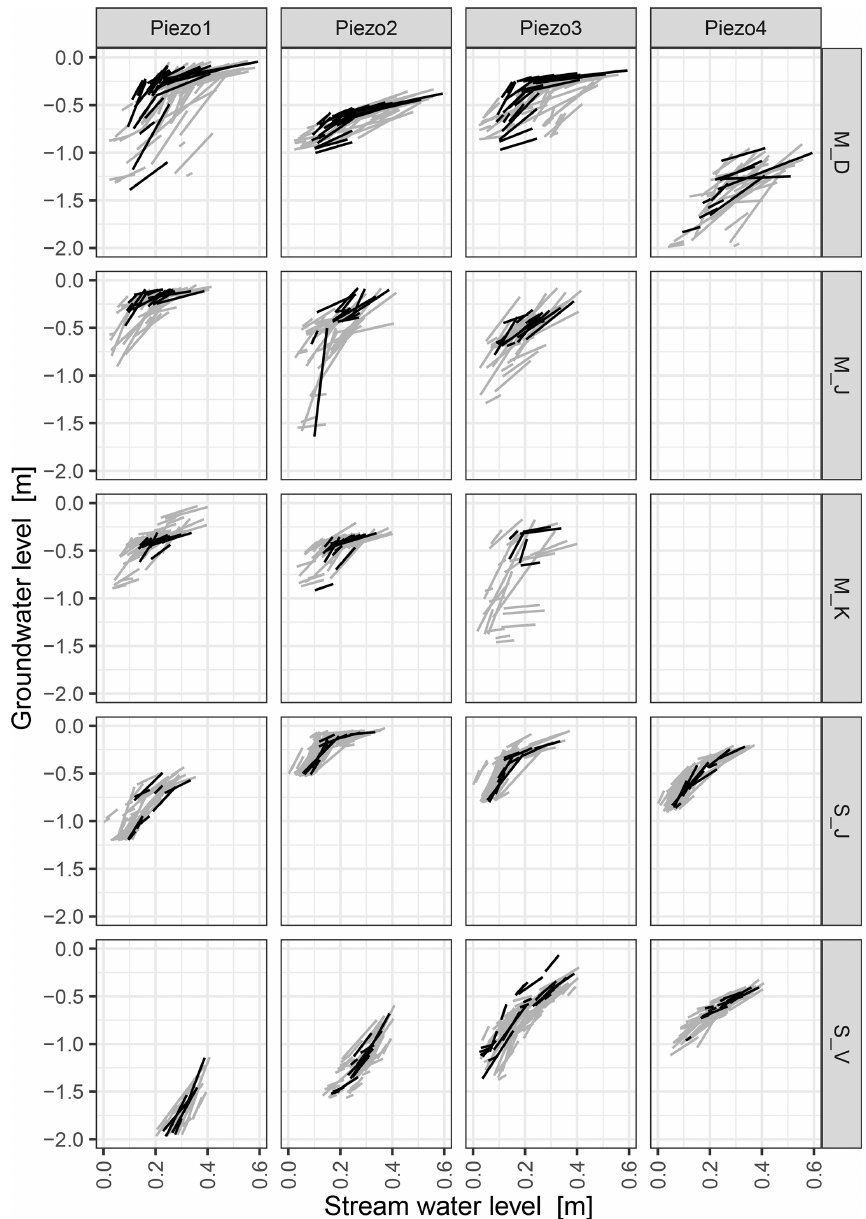
Figure B3. Responses in water tables of groundwater ( y axis) and the corresponding stream ( x axis). Black events are from 2015, while grey events are from all other years. (Replotting of Fig. 10 to visualize the effect of a reduced (1-year) observation